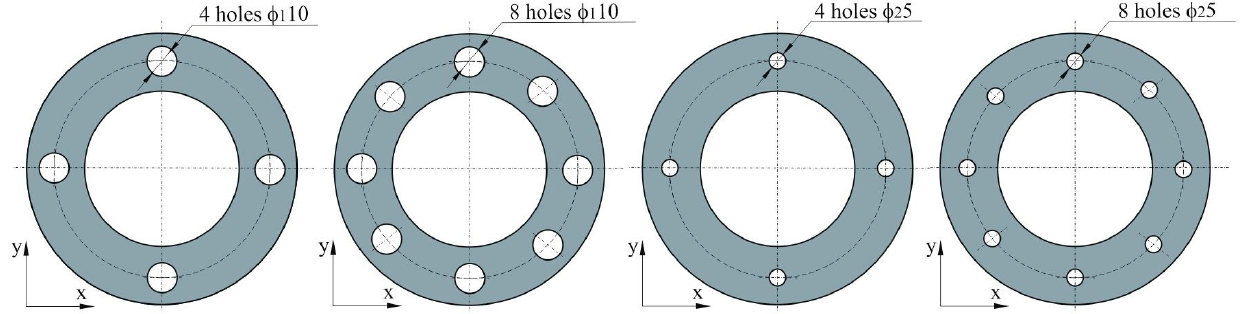
Figure 8. Cylindrical fender models (100 mm × 50 mm × 500 mm) with additional holes inserted.